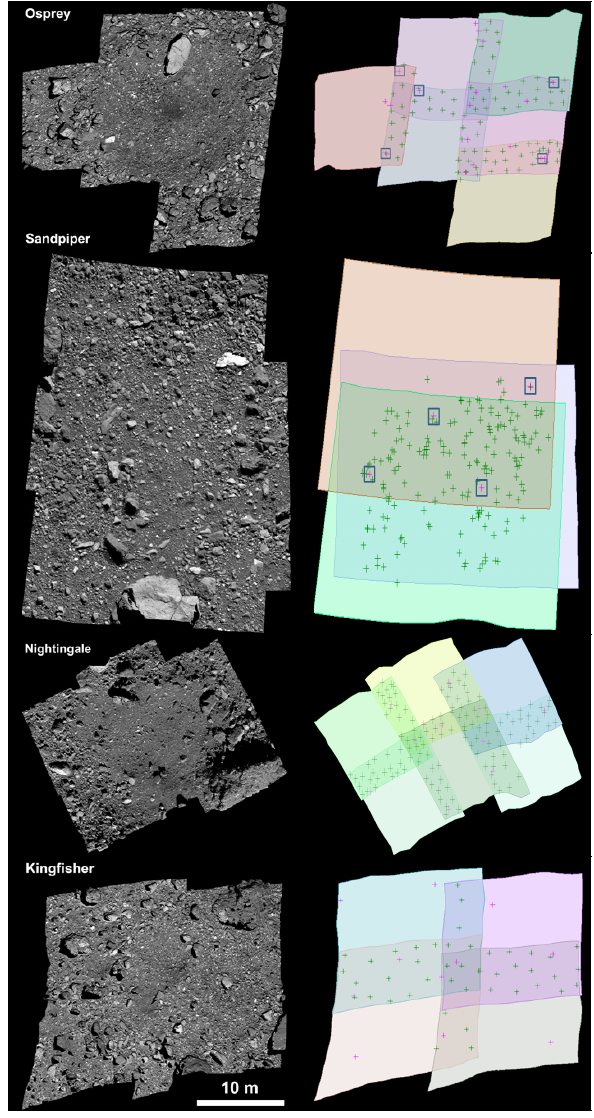
Figure 9. Left: controlled image mosaics of the final four candidate sample sites generated during Reconnaissance A and utilized in the evaluation of safety and sampleability. Right: image footprints corresponding to each mosaic, overlaid with control point